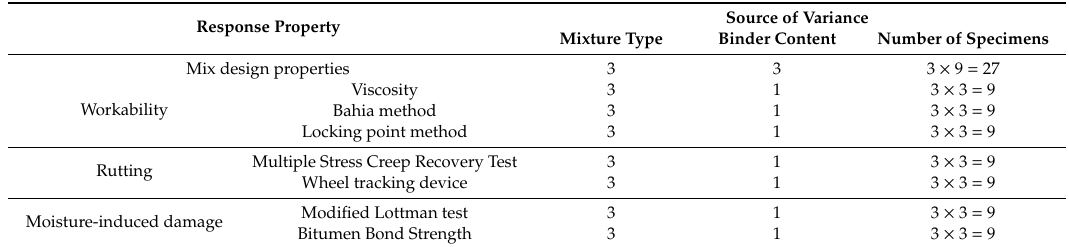
Table 4. Experimental design of the various performance